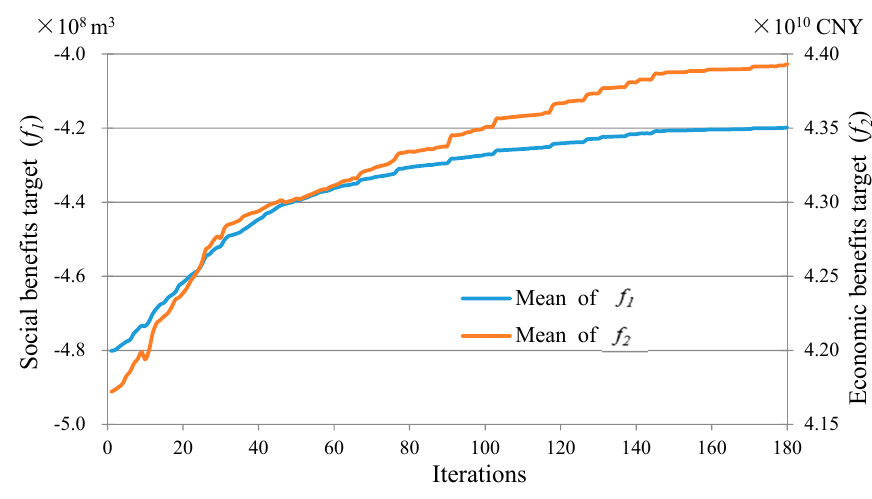
Figure 13. Iterative process of PSO.